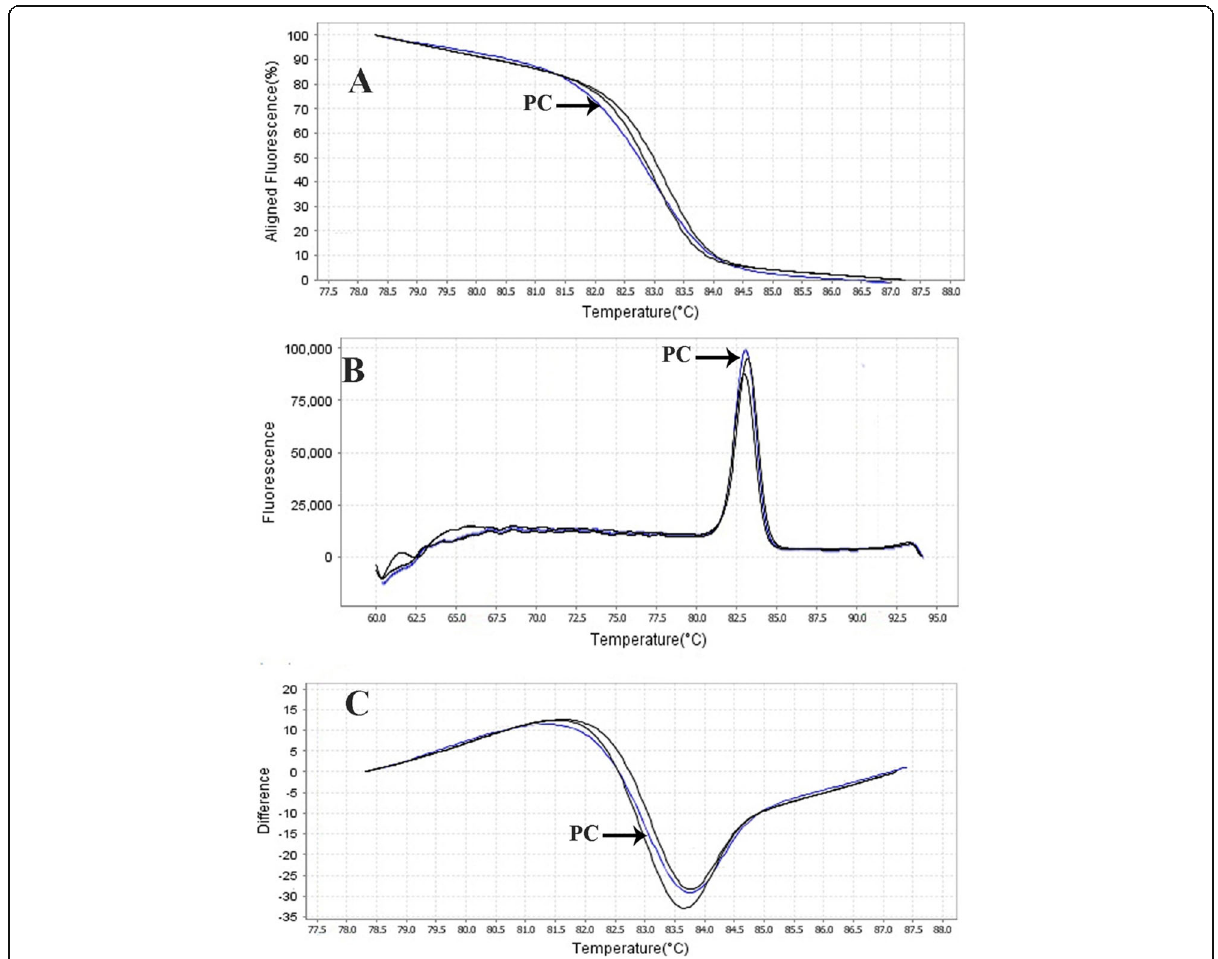
Fig. 7 HRMA graphs corresponding to one high-resolution melting analysis of a subset of clinical specimens of E. faecium . DNA samples in this study were prepared and amplified successfully using the EvaGreen dye-based method in the ABI instrument. Primer-specific melting peaks (Tm) were obtained via HRM analysis, allowing the differentiation of all investigated β -lactamase enzymes. Due to the highly saturating EvaGreen dye and the HRMA analysis, the accuracy of the resolution was ± 0. 1 – 0.5